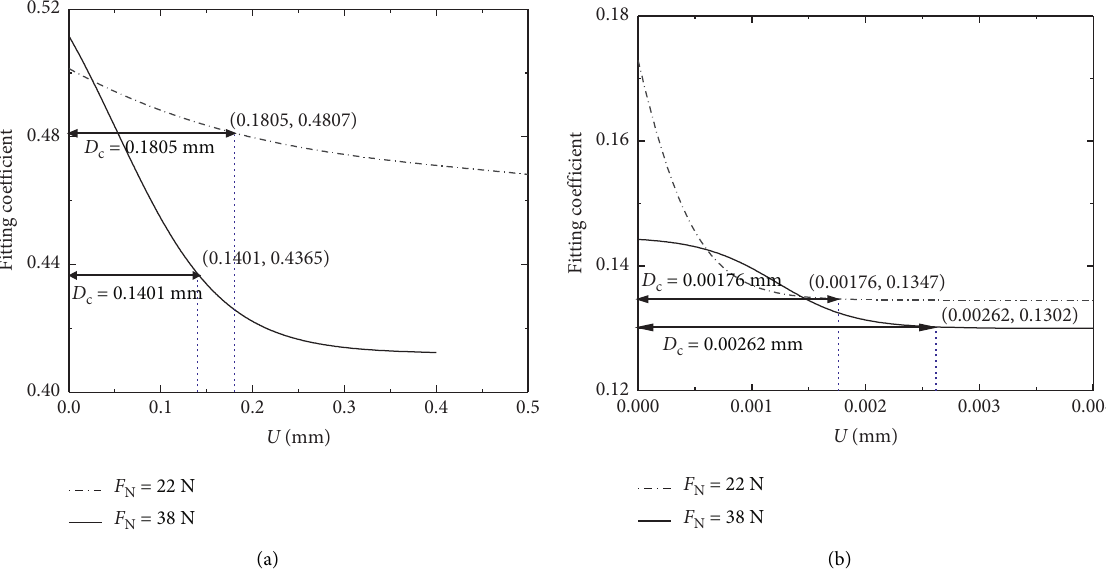
Figure 8: Average friction coefficient μ versus displacement U and the estimated D